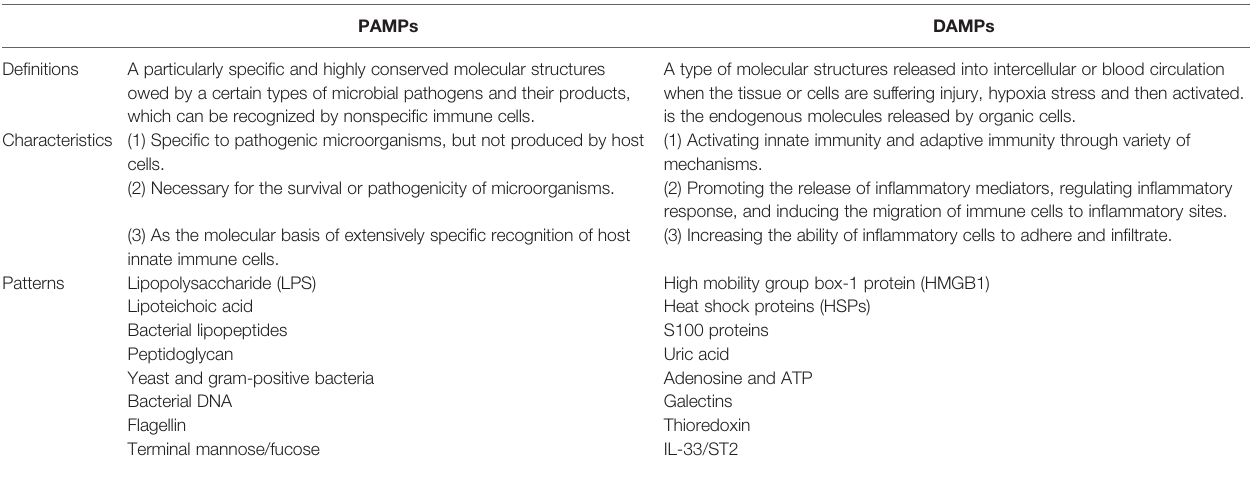
TABLE 1 | Comparisons of PAMPs and DAMPs.